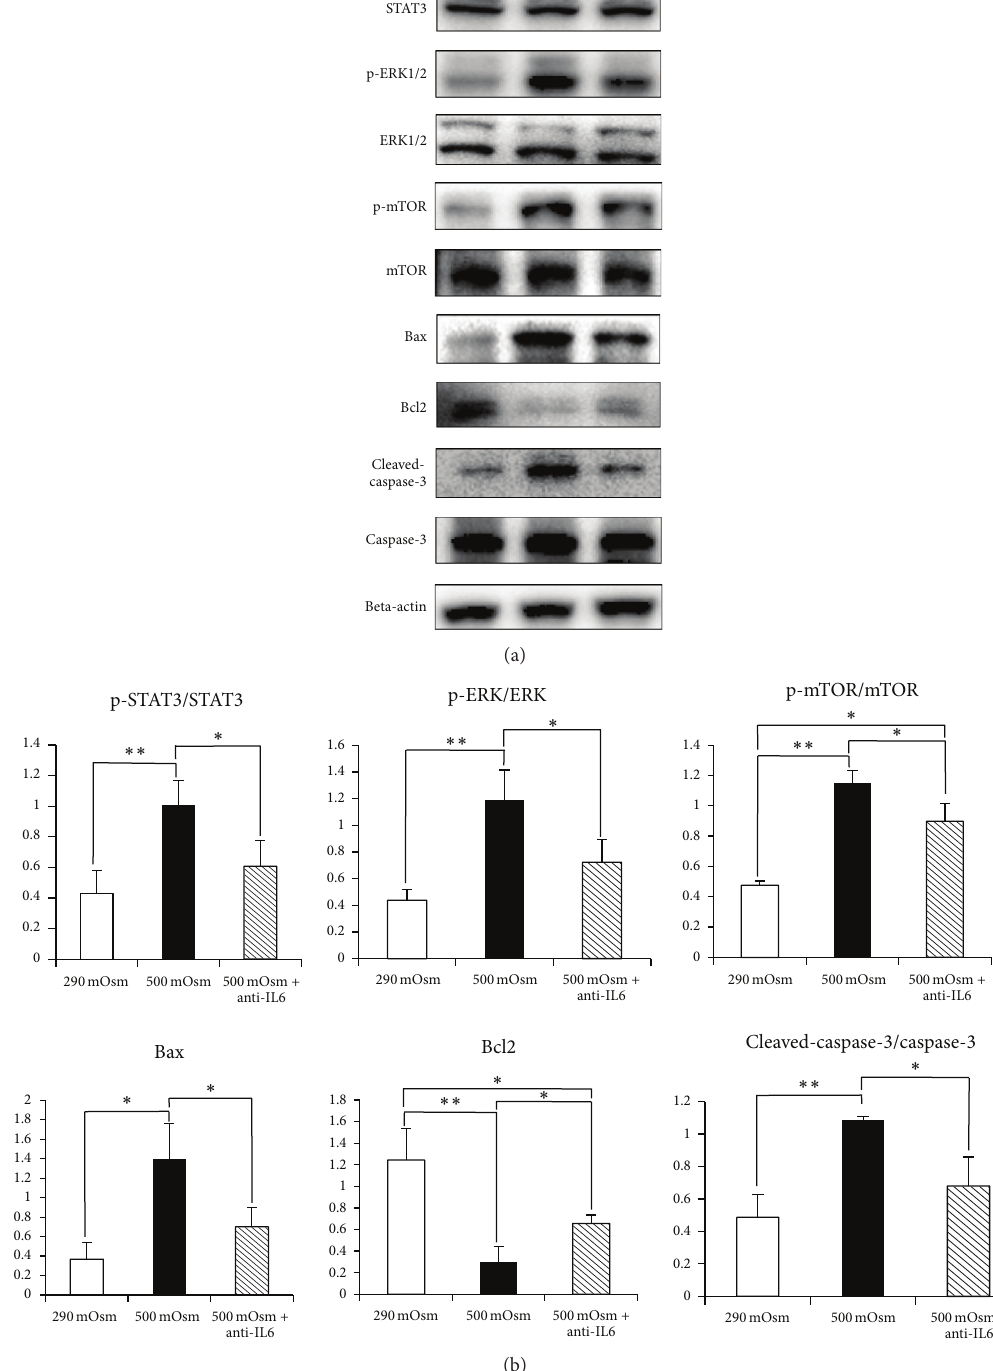
Figure 3: Effect of IL6 on JAK-STAT signaling and apoptosis markers. (a) The factors of the JAK-STAT signaling pathway and apoptosis markers in 500 mOsm and 500 mOsm with anti-IL6 were investigated by Western blot. JAK-STAT signaling was augmented in 500 mOsm and reduced in 500mOsm with anti-IL6, and apoptosis markers also changed in similar pattern. (b) Those differences between 500 mOsm and 500mOsm with anti-IL6 were statistically significant in the graph. ∗ 𝑝 = 0.05 , ∗∗ 𝑝 = 0.05 , 𝑛 = 3